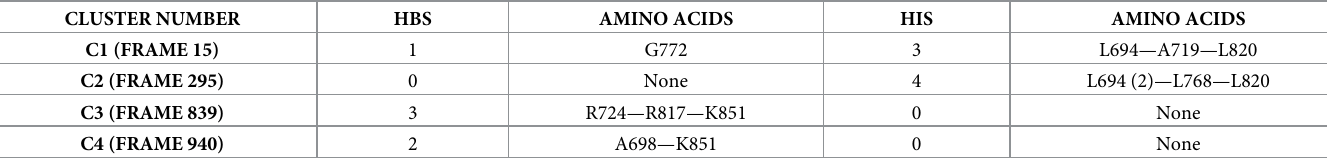
Table 1. Shows the number and types of interactions detected from the PLIP webserver.